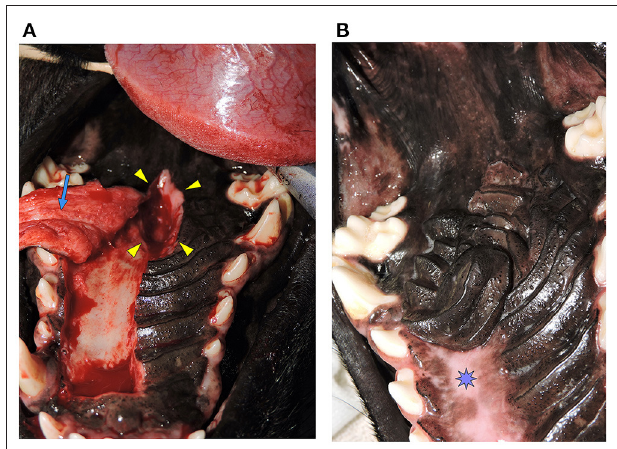
Frontiers in Veterinary Science |